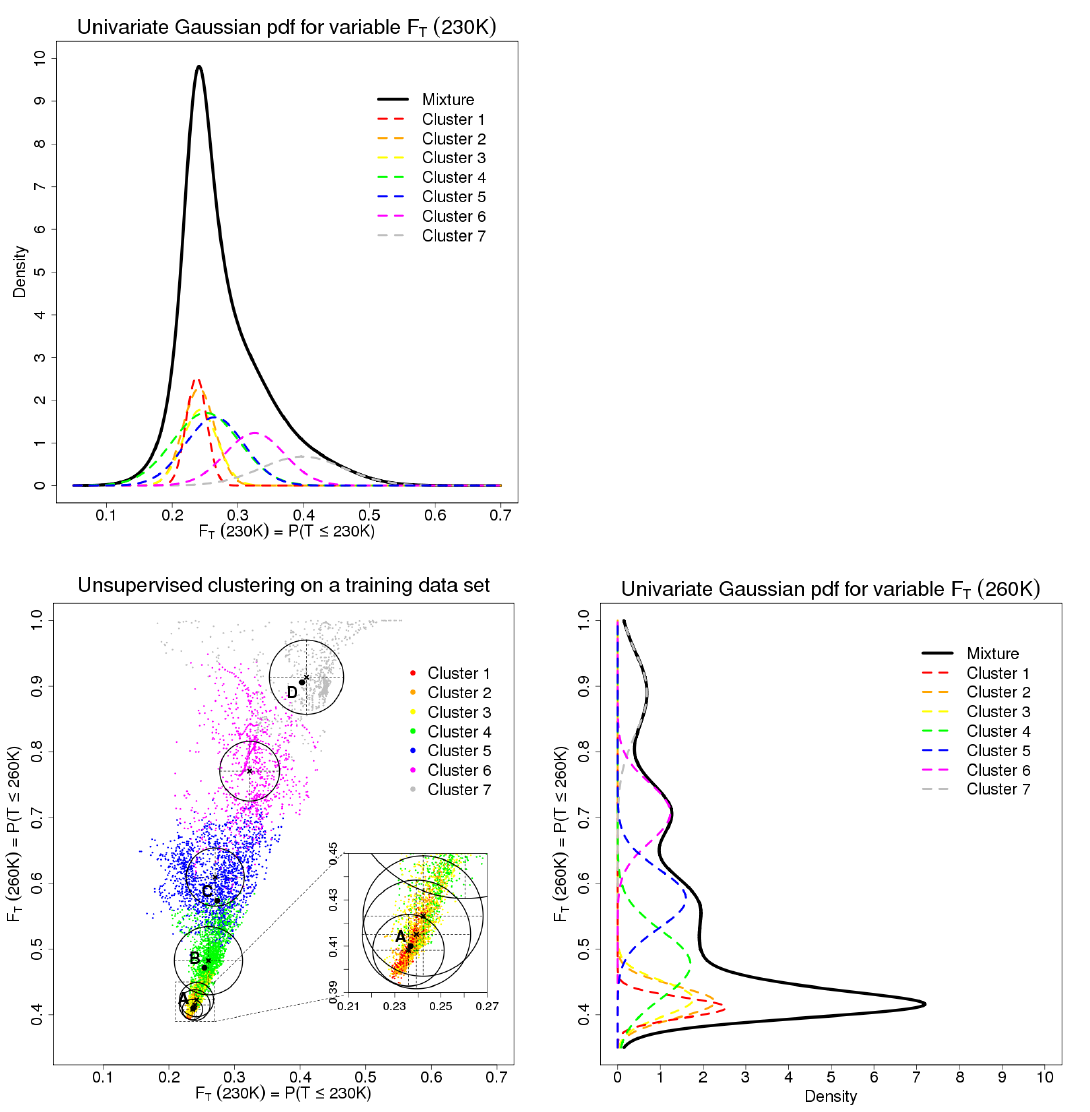
Figure 4. Result of a 20-dimensional multivariate seven-cluster unsupervised classification process via EM-VII (isotropic dispersion which can vary between the clusters) projected in a 2-dimensional subspace, that is, for the variables F T (230K) and F T (260K) here. The radius of each circle indicates the standard deviation of the cluster where each of the atmospheric situations is represented by a point (the four situations of Fig. 3 are also indicated). The adjacent plots represent, for each of the two variables chosen for the projection, the associated univariate densities per cluster (the full width at half maximum corresponds to the diameter of the associated circle) or for the